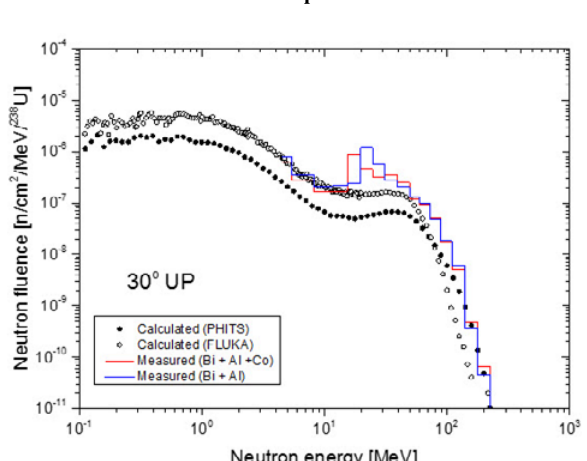
Figure 3 : Angular distribution of radionuclide yields in Bi samples.